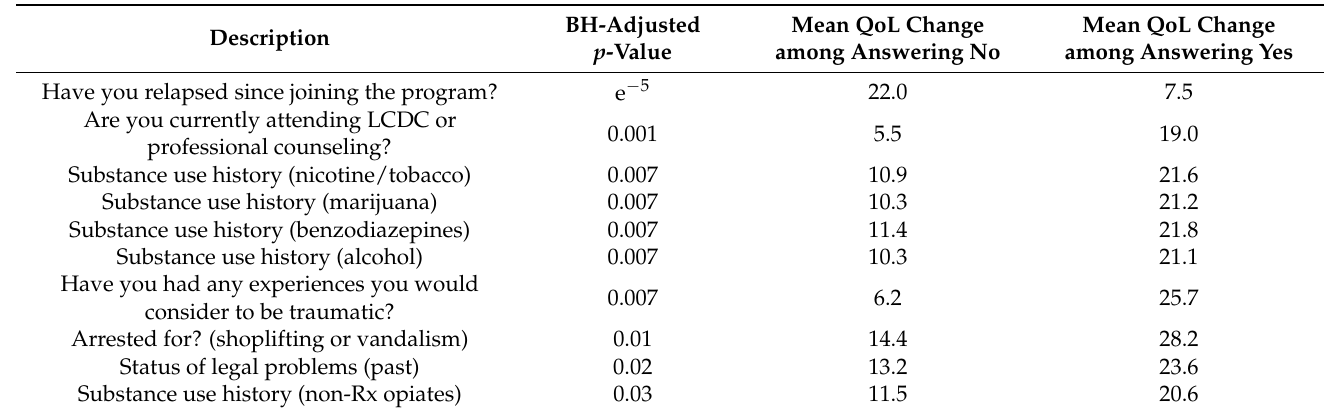
Table 2. Significant factors associated with change in QoL.